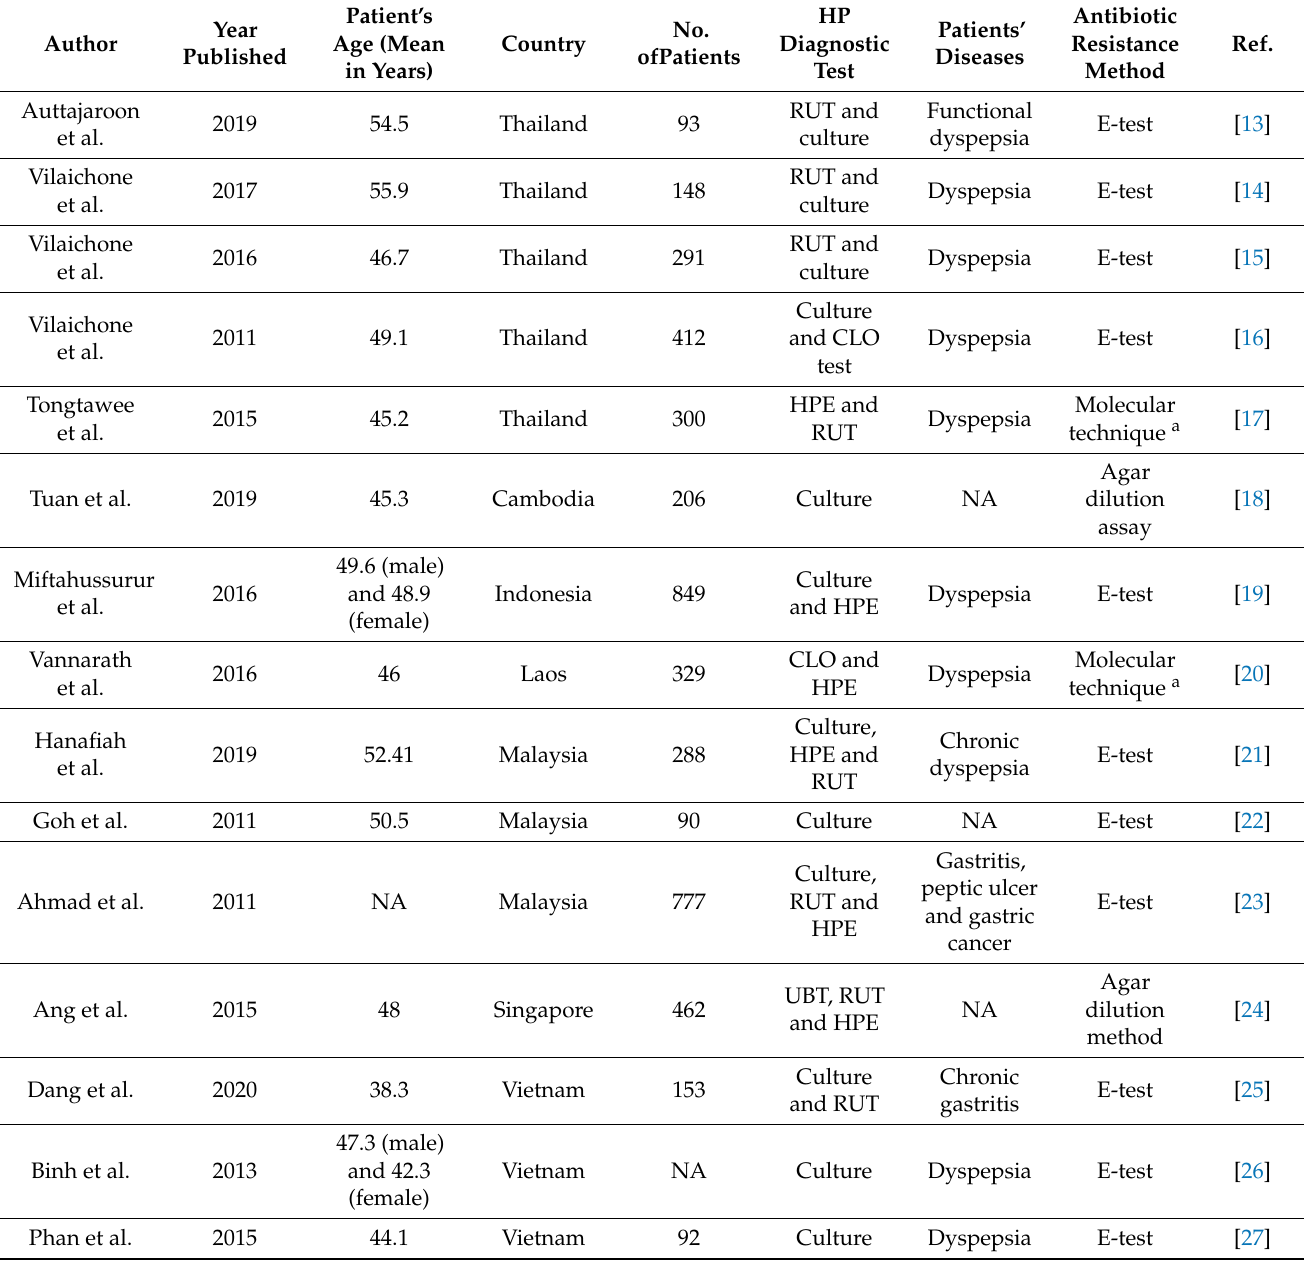
Table 1. List of studies included in the systematic